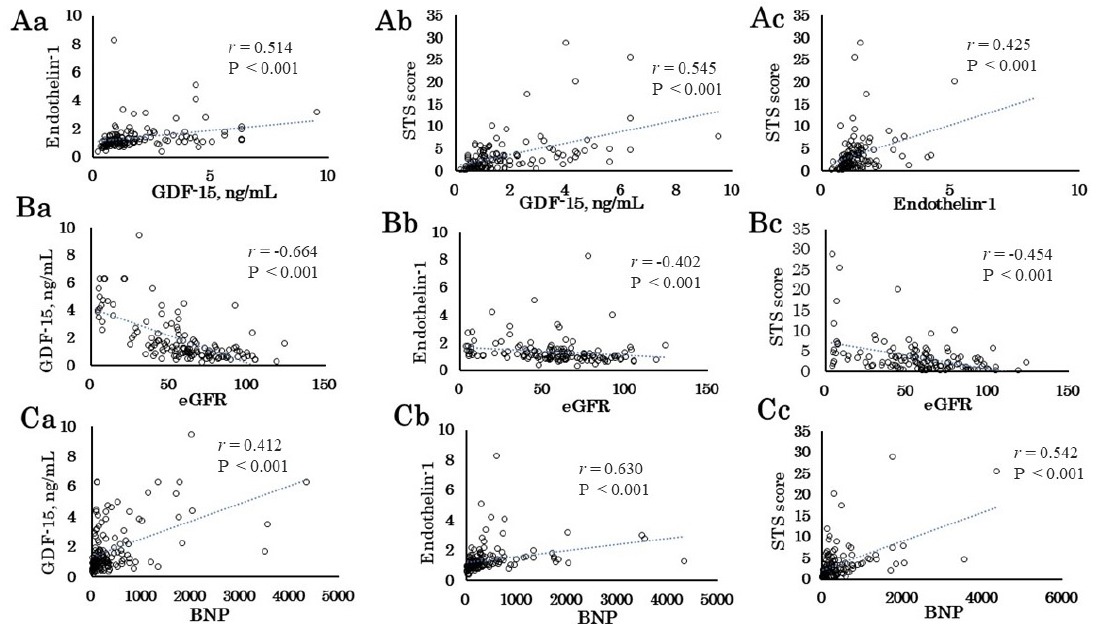
Figure 1. Correlations between clinical data and preoperative GDF-15, ET-1 level, and STS score. ( A ) Correlations between preoperative GDF-15 level, ET-1 level, and STS score. ( B ) Correlations between eGFR and preoperative GDF-15 level ( Ba ), ET-1 level ( Bb ), and STS score ( Bc ). ( C ) Correlations between BNP and preoperative GDF-15 level ( Ca ), ET-1 level ( Cb ), and STS score ( Cc ).